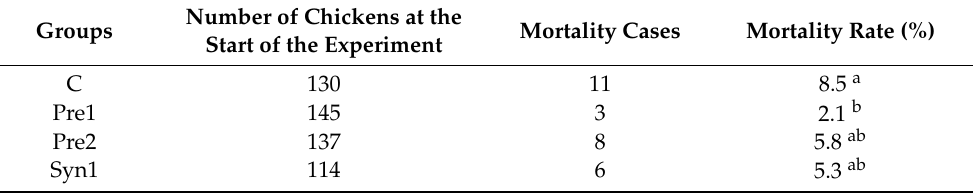
Table 3. Mortality rate in pre- and symbiotic-treated chickens. C – control, Pre1 – prebiotic 1, Pre2 – prebiotic 2, Syn1 – synbiotic 1, and Syn2 – synbiotic